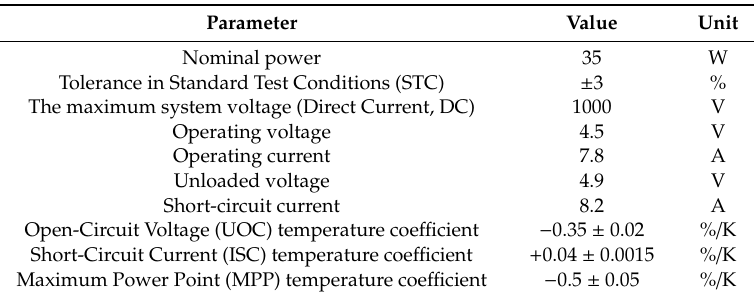
Table 2. Electrical parameters of the photovoltaic roof tile [26].